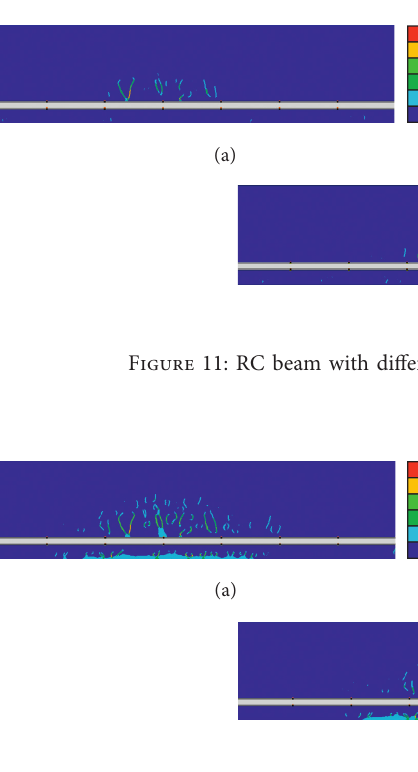
Figure 12: RC beam under different corrosion expansion pressures with 25% aggregate content: (a) 2%, (b) 3%, and (c) 3.5%.